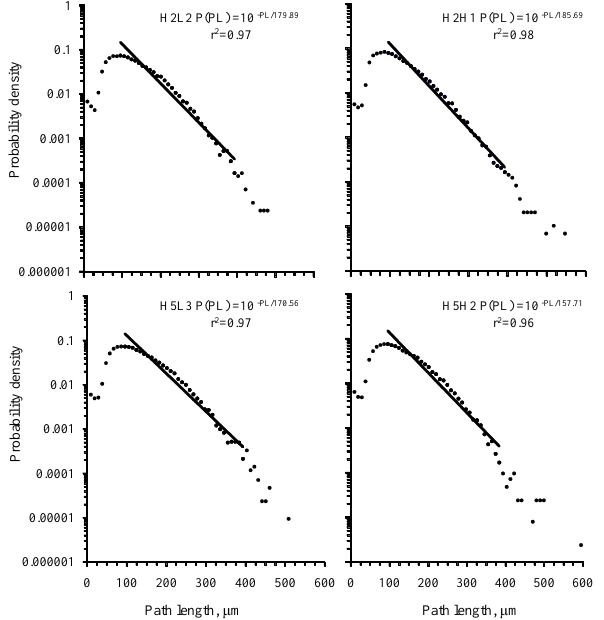
Figure 5. Probability density distributions versus pore path length for Hamra 2.0 and 0.5mm aggregate treatments (H2 and H5) and low- and high-compaction treatments (L and H). Selected replicates are shown in the figure (last number in treatment name is replicate). Path length (PL) is the length of the path between adjacent con- nected nodal pores and PLo is the characteristic path length con- stant, which is the value in each equation.